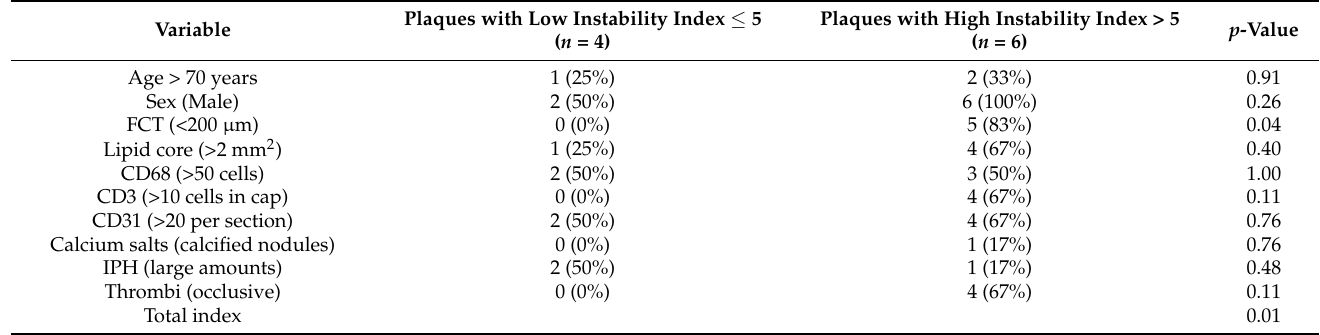
Table 3. Clinical, histological, and immunohistochemical characteristics of carotid plaques.